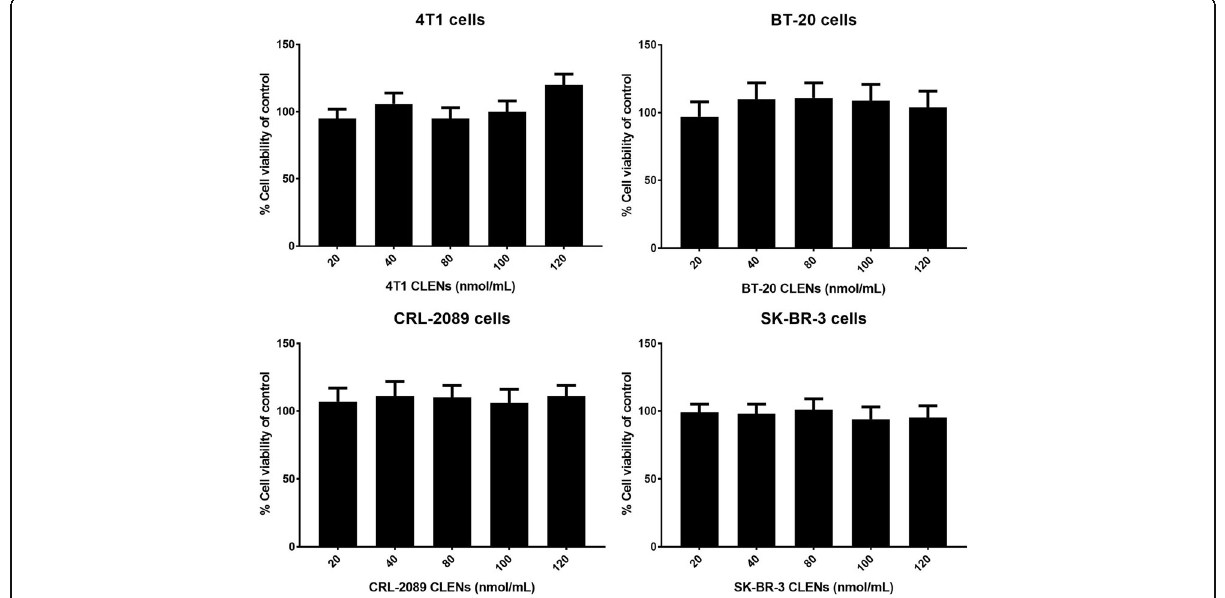
Fig. 1 In vitro toxicity profile of CLENs. Cells were seeded at 1 × 10 4 cells/mL in a 48 well plate and incubated at 37 °C. Percent of cell viability was determined following 24 h of exposure to 10 μ mol/mL of respective CLENs. CLENs were added to plates seeded with the same cell line used in the general extraction and development of CLENs; a) 4 T1 cells were exposed to 4 T1 CLENs, b) BT-20 cells were exposed to BT-20 CLENs, c) CRL-2089 cells were exposed to CRL-2089 CLENs and d) SKBR-3 cells were exposed to SKBR-3 CLENs. Data are presented as mean ± S.D.; ( n =